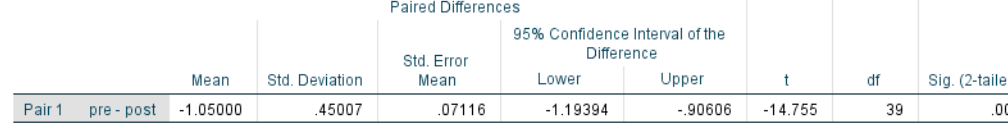
Figure 4. Paired Samples Correlations.